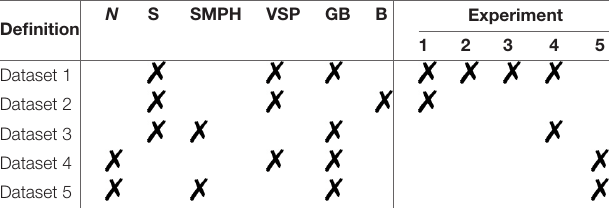
TABLE 1 | Definitions of the used